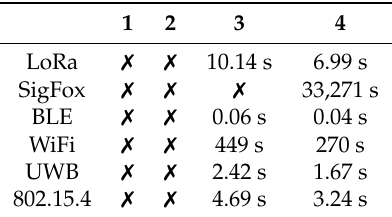
Table 8. Time a device has to spend in the most energetic gait (canter) before a packet of 8-12 bytes can be send. BLE is the best suited for efficient transmissions between sender and receiver. However, even for BLE if the transceiver and/or MCU are not put in to sleep after processing and transmission of the data, the node will never be feasible.